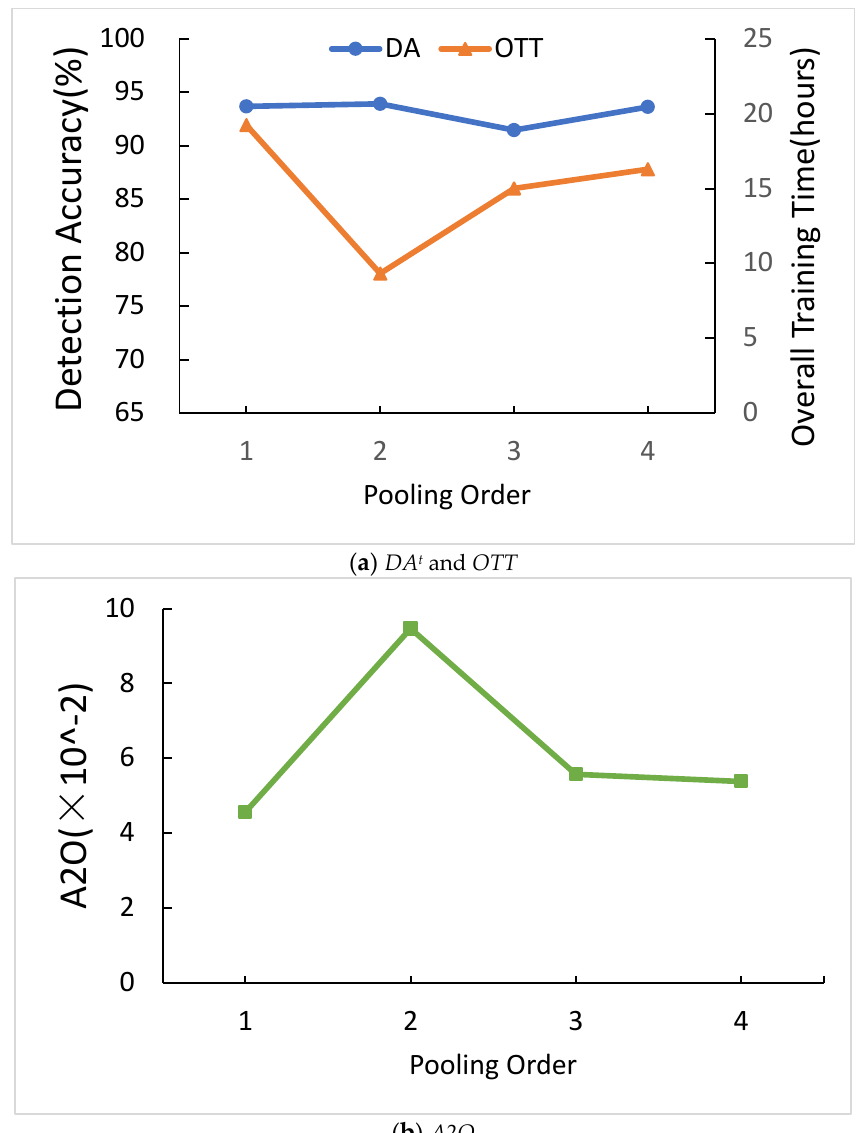
Figure 12. Comparison of different orders of pooling in CNN.